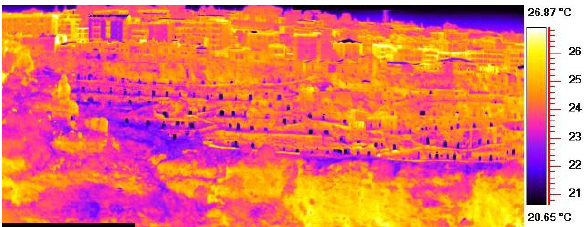
Figure 2. Mosaicking of thermograms processed with the aid of the software NRG © Microgeo